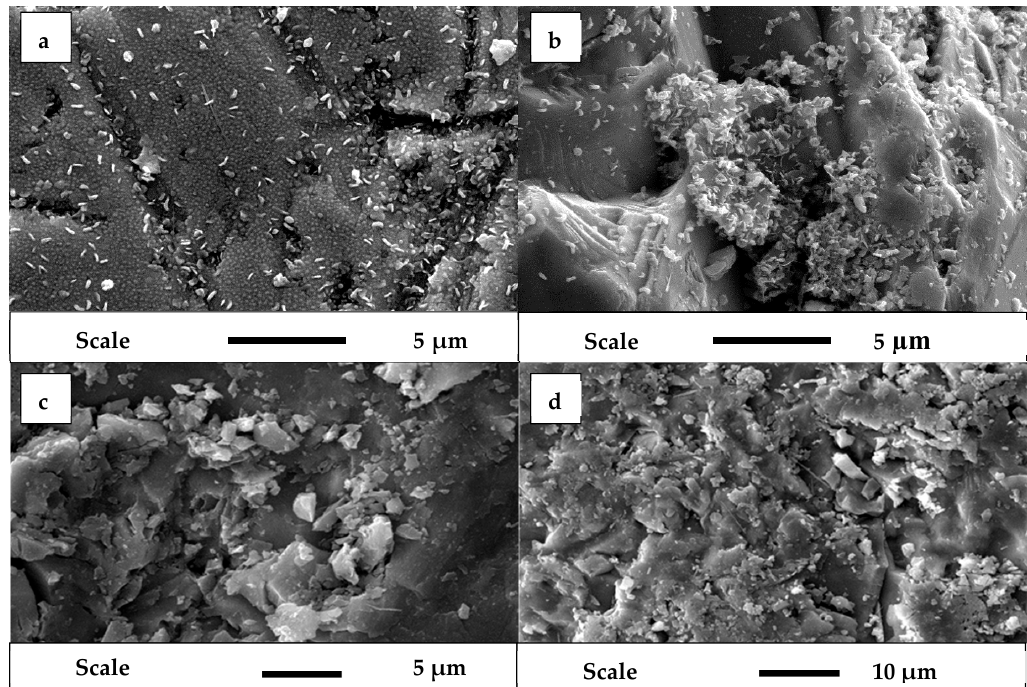
Figure 3. SEM image of Cp surface exposed to L.f at ( a ) 2 h, ( b ) 24 h, ( c ) 48 h, and ( d ) 72 h at a magnification of 1000× ( a ), 1200× ( b ), 1500× ( c ), and 6500× ( d ).